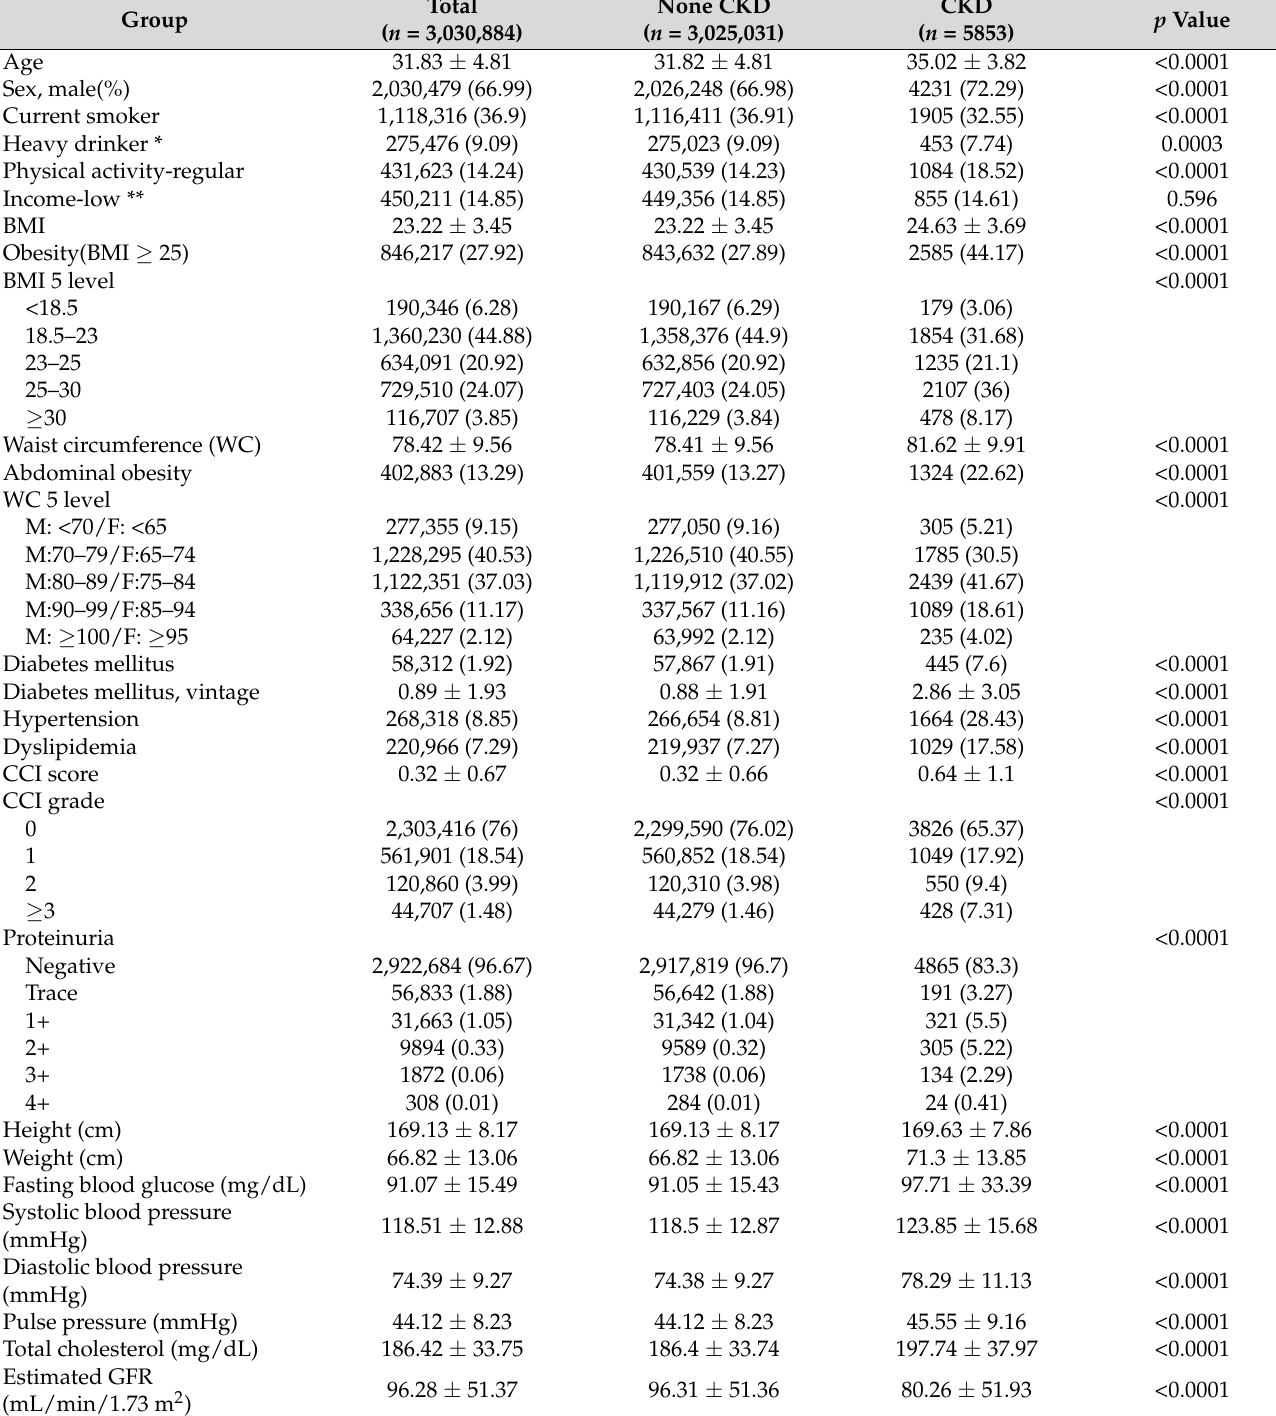
Table 1. Baseline characteristics of subjects according to the incident chronic kidney